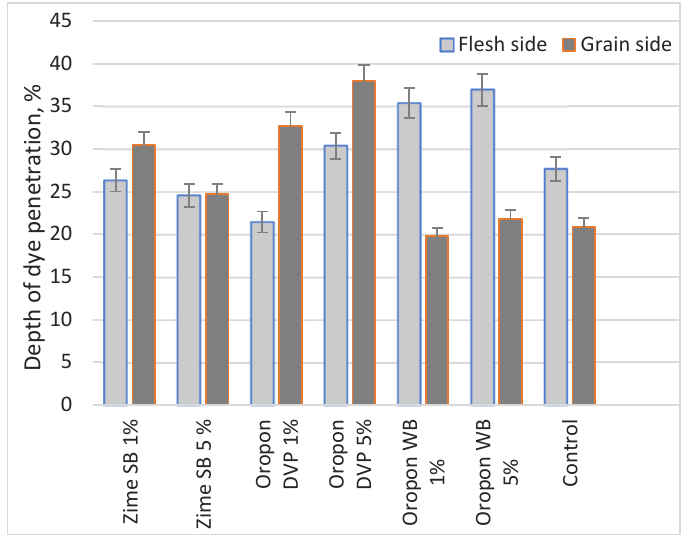
Figure 2. Depth of dye penetration using different EP. The thickness of the wet blue leather samples was within 1.65–1.70 mm.